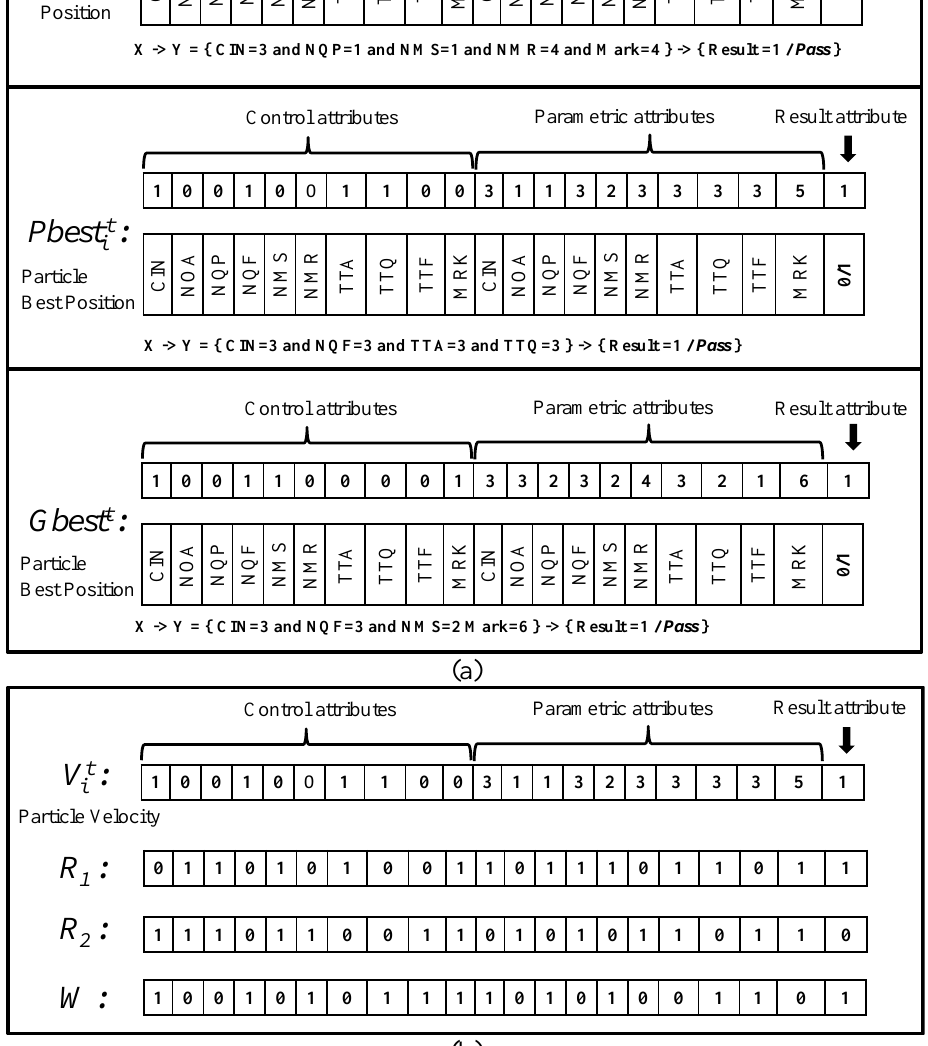
Figure 7. Samples of particle position, Pbest and Gbest particles (a), velocity particle, R 1 , R 2 , and W vectors